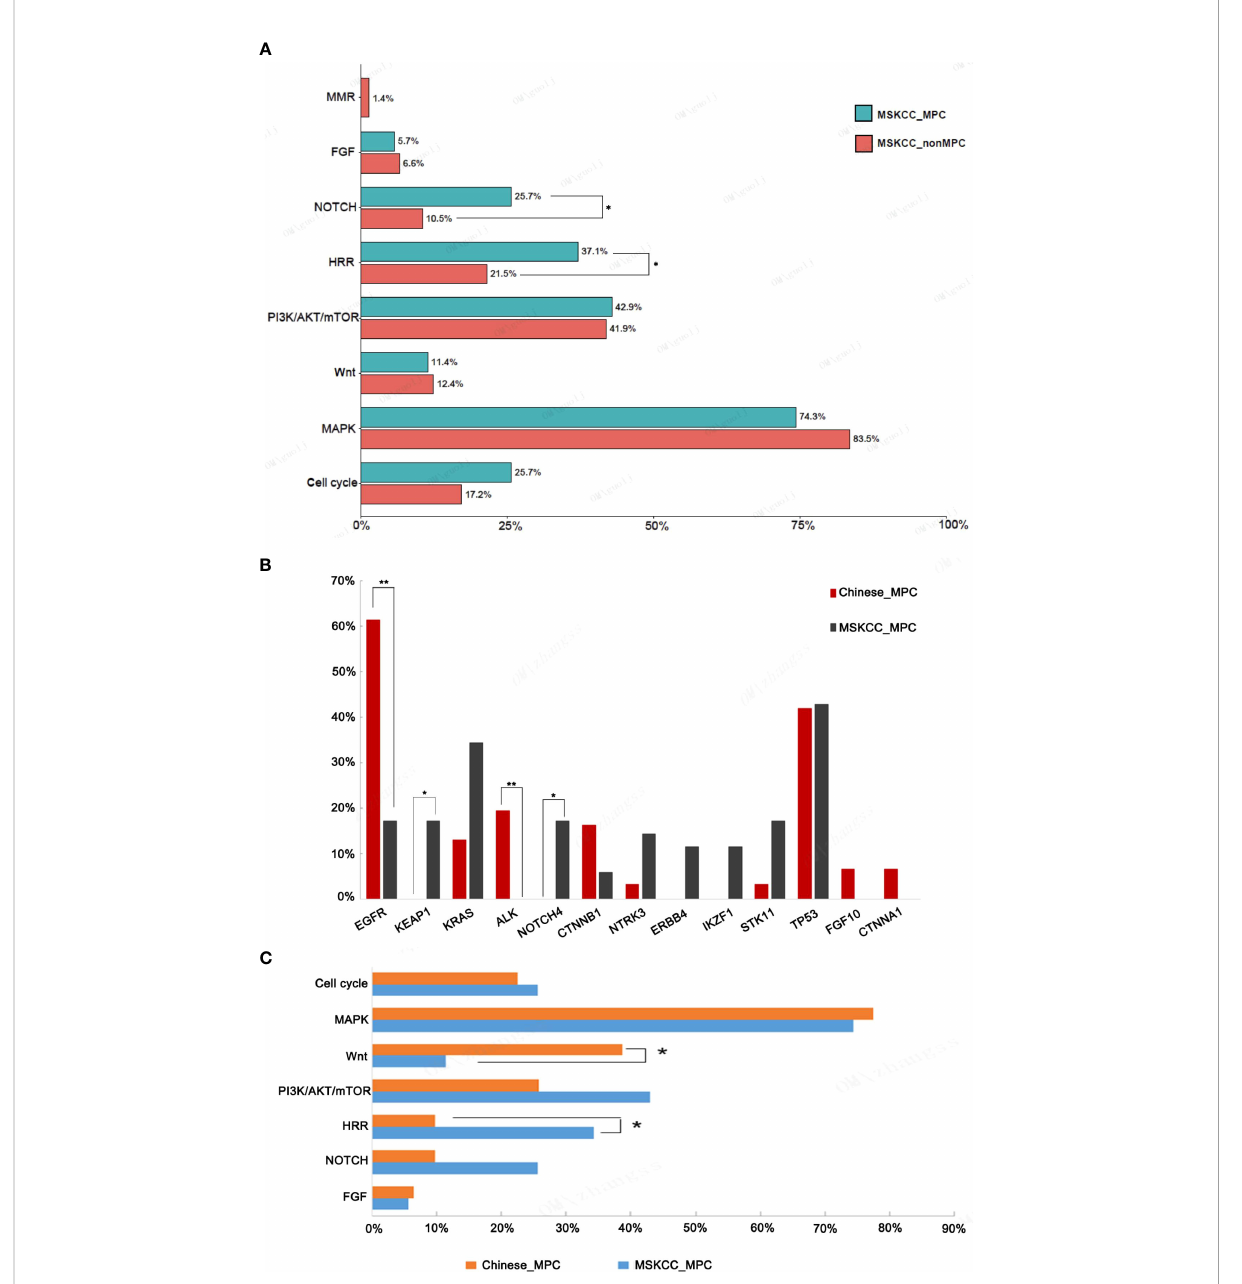
FIGURE 5 A comparison of gene mutations in the Chinese LAMPC and MSKCC LAMPC cohorts. (A) A comparison of the frequency of pathway changes between MSKCC_MPC and MSKCC_non-MPC patients. A comparison of frequencies for (B) main driver gene alterations and (C) pathways changes in the Chinese LAMPC and MSKCC LAMPC cohorts. * p < 0.05, ** p <